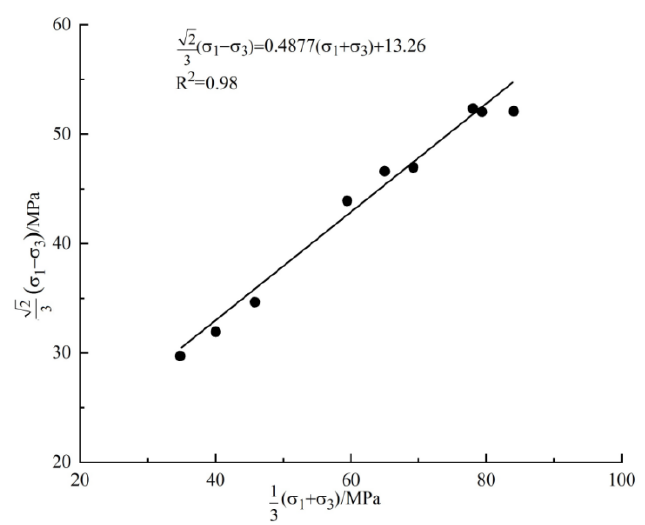
Figure 7. Mogi–Coulomb strength criterion: fitted data.